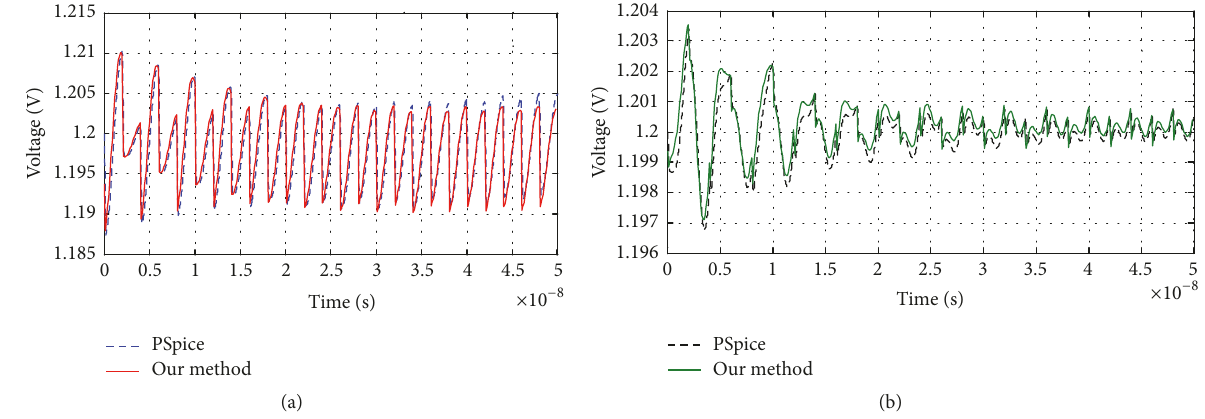
Figure 9: SSN waveform of the PDN near the second core; 𝐶